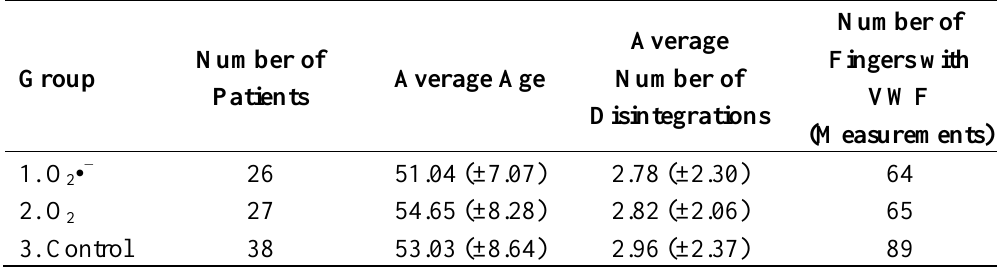
Table 1. Characteristics of the three